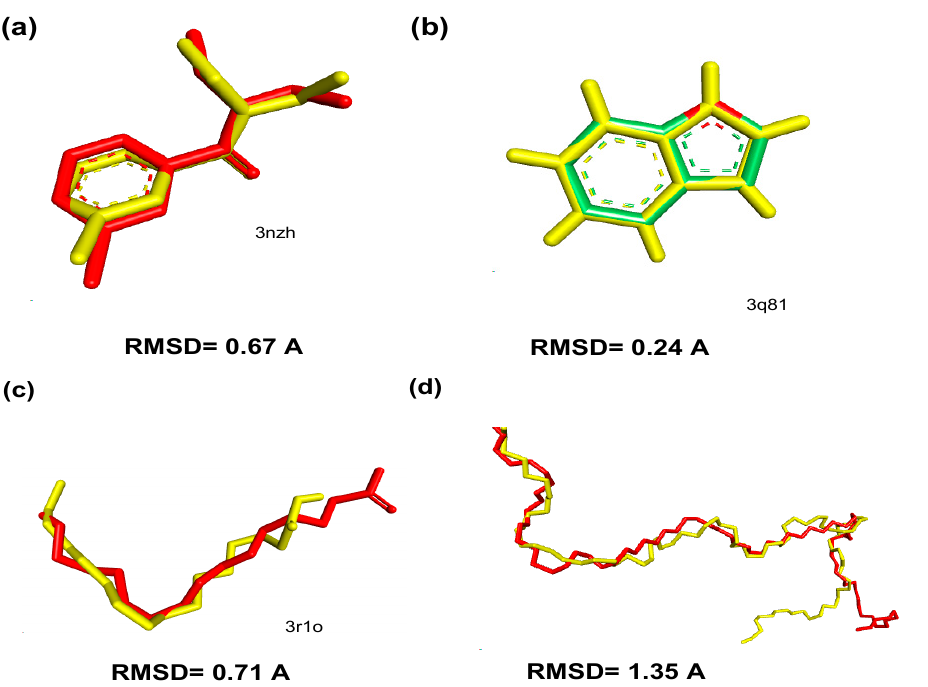
Figure 9. Crystallographic complexes (in red) overlapping with estimated poses (in yellow): ( a ) OBP 1 (PDB 3N7H), ( b ) OBP 4 (PDB 3Q8I), ( c ) OBP 7 (PDB 3R1O), and ( d ) OBP (PDB 2ERB).